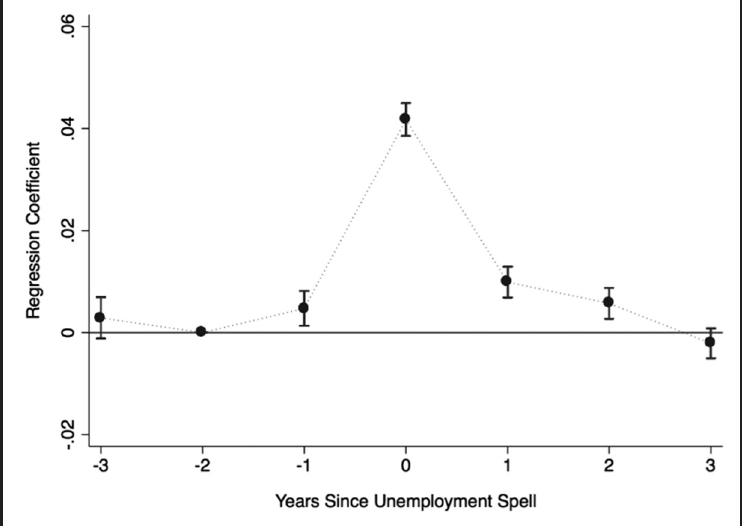
Figure 2 Coefficients from regression of family transfers on years since unemployment, heads of household and spouses aged 19–59 years, 1976–2013